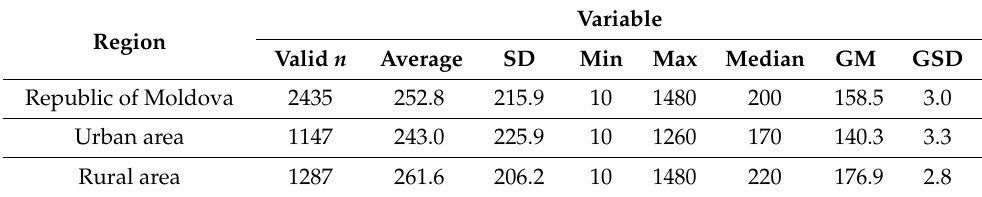
Table 3. Descriptive statistics of the dataset from the national indoor radon survey in 2019. Region